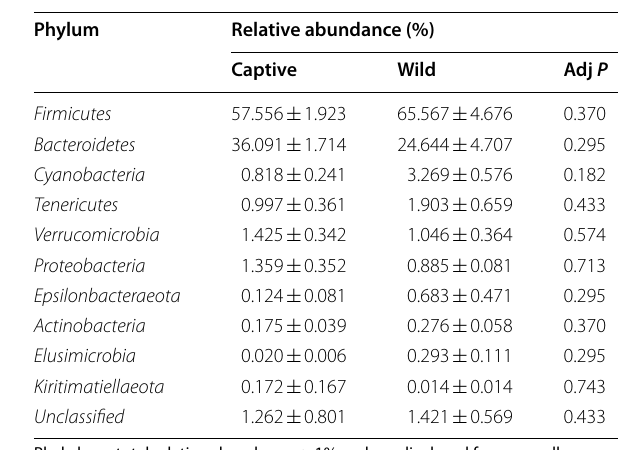
Table 1 Phyla relative abundances in summer Captive and Wild mucosa